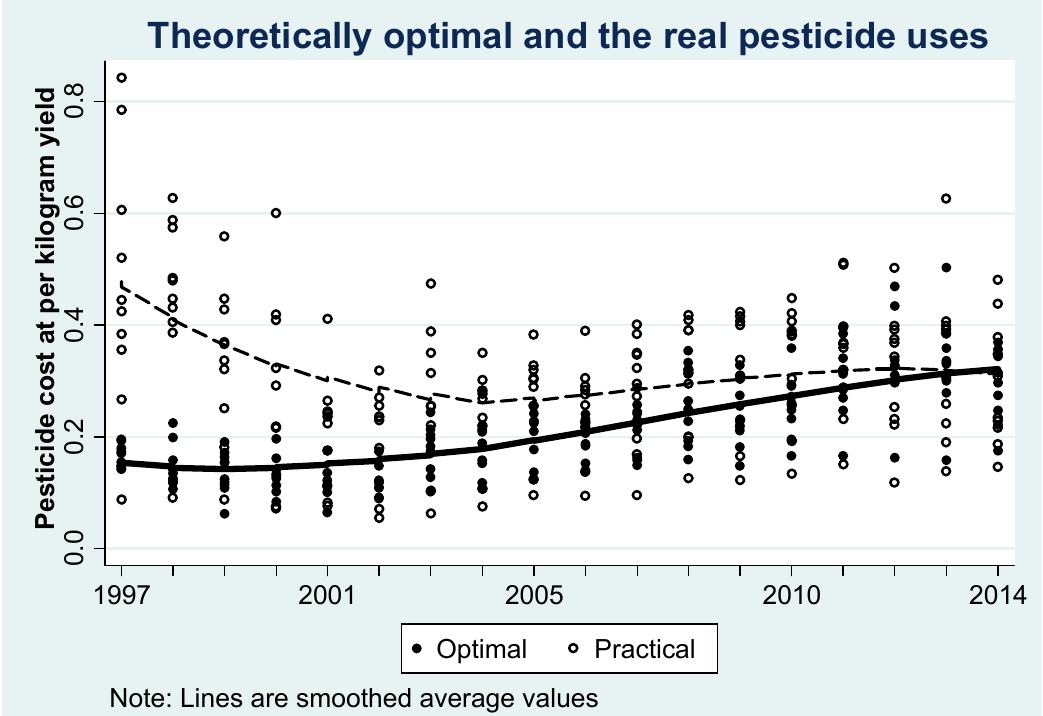
Figure 5. The theoretically optimal and the real pesticide uses.